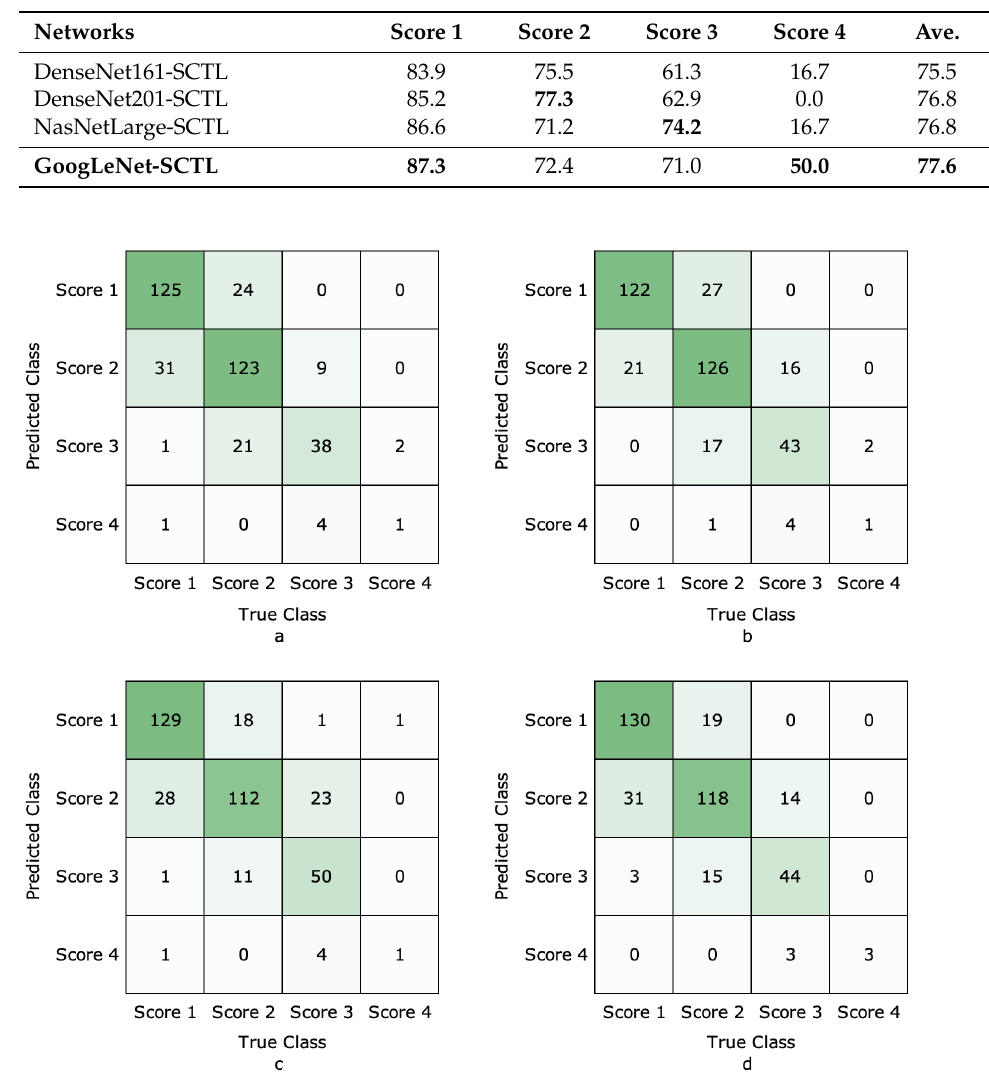
Figure 4. Confusion matrix of DenseNet161-SCTL, DenseNet201-SCTL, NasNetLarge-SCTL, and GoogLeNet-SCTL models. ( a ) DenseNet161-SCTL, ( b ) DenseNet201-SCTL, ( c ) NasNetLarge-SCTL, ( d )